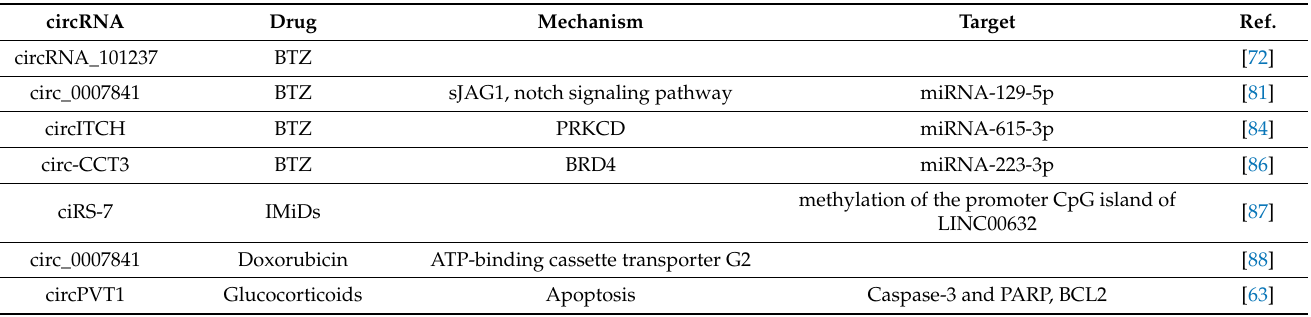
Table 2. CircRNAs and chemoresistance in multiple